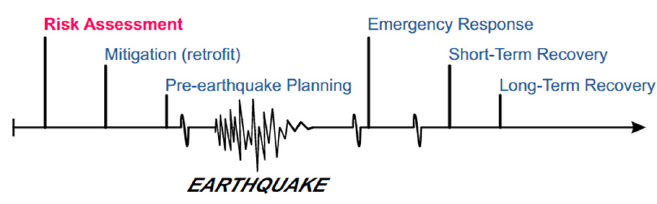
Figure 1. A disaster risk assessment management problem [2].